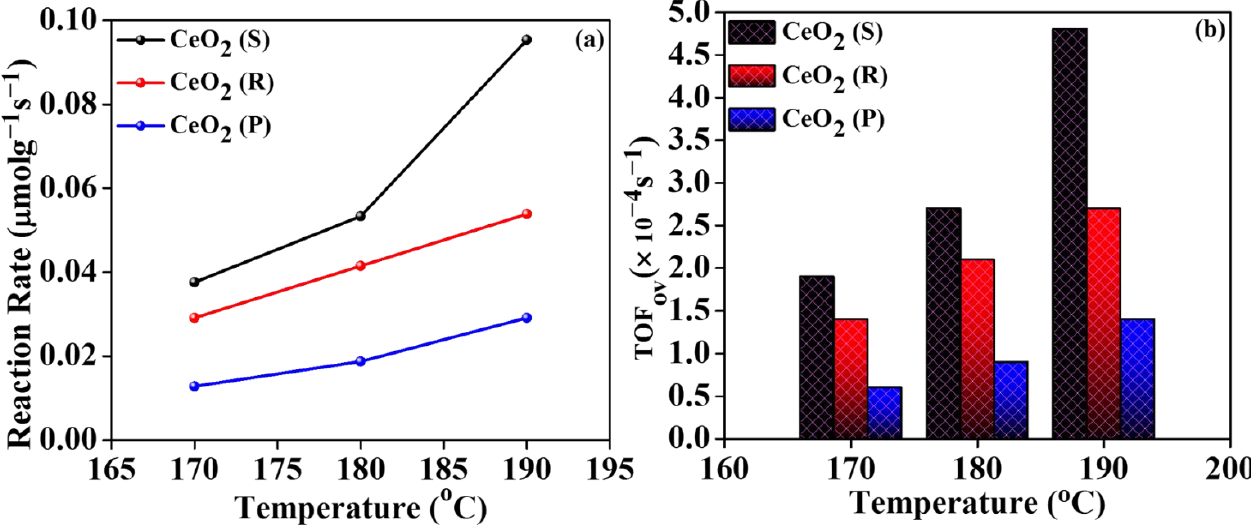
Figure 7. Reaction rate ( a ) and TOF ov ( b ) over CeO 2 (S) at 170, 180, and 190 ° C .